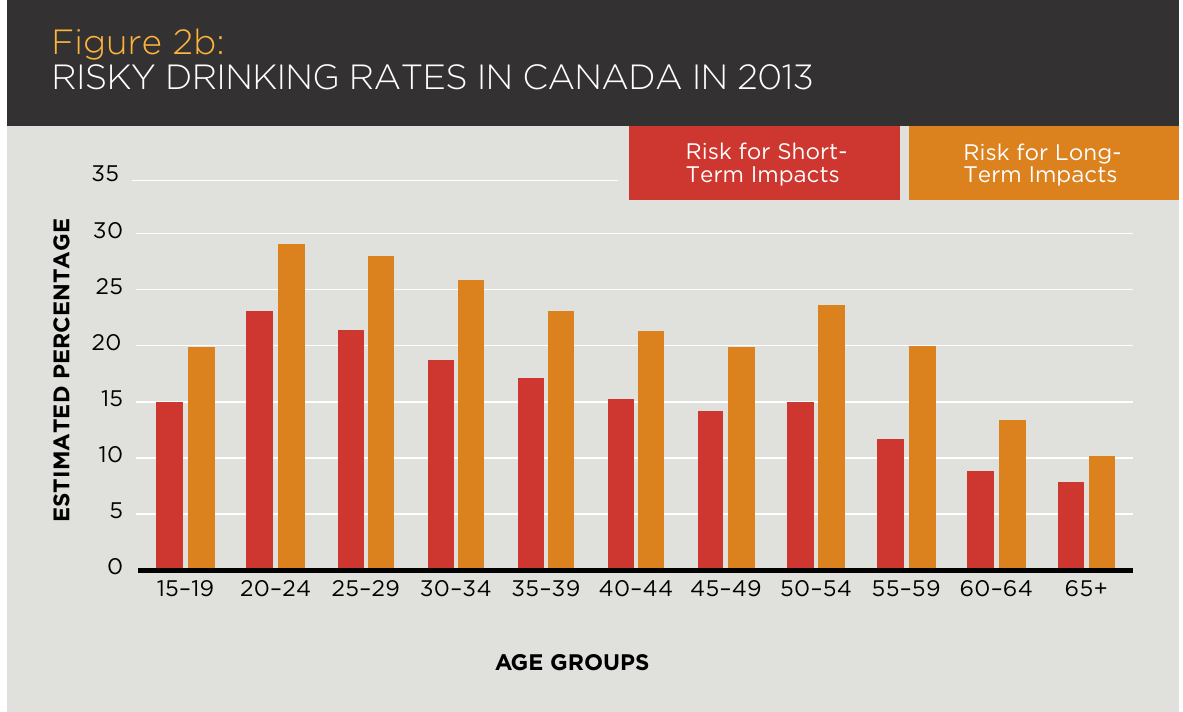
RISKY DRINKING RATES IN CANADA IN